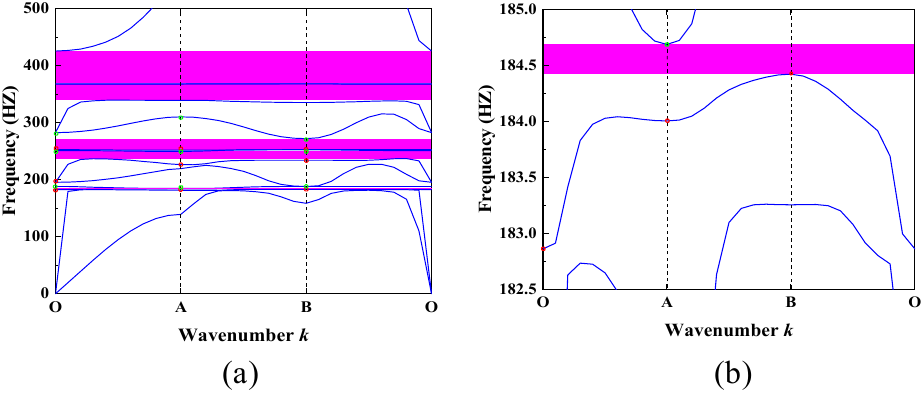
Figure 2. ( a ) Band structure of the SHMLRAS and ( b ) detailed schematic of the first bandgap. The application of point group theory, which is used extensively in physics and molecular chemistry, to analyze and predict the electromagnetic response of complex structures is a highly rewarding endeavor [39]. However, the mode analysis approach used in these works [38,40] more easily helps us to understand the mechanism of bandgap generation. The vibrational modes at Points O, A, and B are analyzed below for the upper (green circles) and lower (red circles) dispersion curves corresponding to the former three bandgaps in Figure 2a. The size and direction of the arrows in the mode shape diagrams represent the displacement distance and direction of the structure relative to its original position. Figure 3 shows the mode shapes at Points O, A, and B for the upper and lower boundaries of the first bandgap respectively. It can be seen that the displacement and direction of the mode shapes at the upper and lower boundaries of the fourth (1st upper) and third (1st lower) dispersion curves corresponding to the Point O are very similar in the second and fourth quadrants. In the first and third quadrants, however, the directions of the modes are opposite. At Point A, we can notice a clear exchange of energy in the structural vibrations, with the spiral vibrations in the second and fourth quadrants becoming the spiral vibrations in the first and third quadrants. In the A → B direction, attenuation occurs in the vibration modes corresponding to the fourth and third dispersion curves. Moreover, the 1st up vibration in the second and fourth quadrants decays significantly, which leads to the spiral vibration in the first three quadrants. Comparing Figure 2b with the previous discussion, we can see that the energy exchange occurring at Point A is the main reason for the creation of the first bandgap.